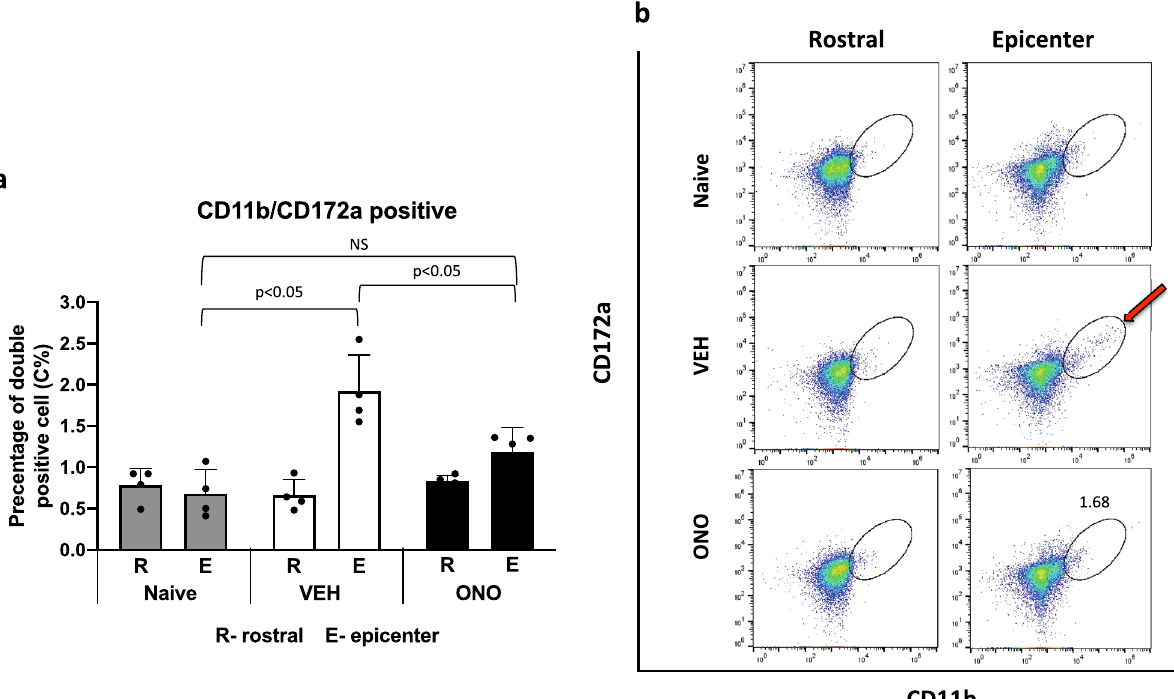
Figure 4. Flow cytometric analysis data of increased immune cells after modulation of the ATX activity. ( a ) CD11b/CD172A double-positive cells were counted and depicted as percentile from total cell number comparing epicenter (E) or rostral (R) sections of the spinal cord in naive, VEH and ONO groups at day 14 after model development. CD11b/CD172A double-positive cells were not different between groups in rostral section, whereas in epicenter section, significant (p < 0.05) increase of the cell numbers counted in the VEH group. In the ONO group double—positive cells did not differ from the naive group in epicenter (E) section. ( b ) Flow cytometric analysis and plot of elliptical area indicated the CD11b/CD172A double-positive cells. Arrow indicates increased immune cells (CD11b/CD172A double-positive) into the epicenter (E) section in the VEH group. In the ONO group amount of the immune cell were equivalent to that of naive group, showing the effect of the ATX inhibitor. Values represent the mean percentile ± SD (n = 3) and significant differences between groups analyzed by one-way ANOVA: VEH, ONO groups with naïve and paired t-test: VEH, ONO groups between each